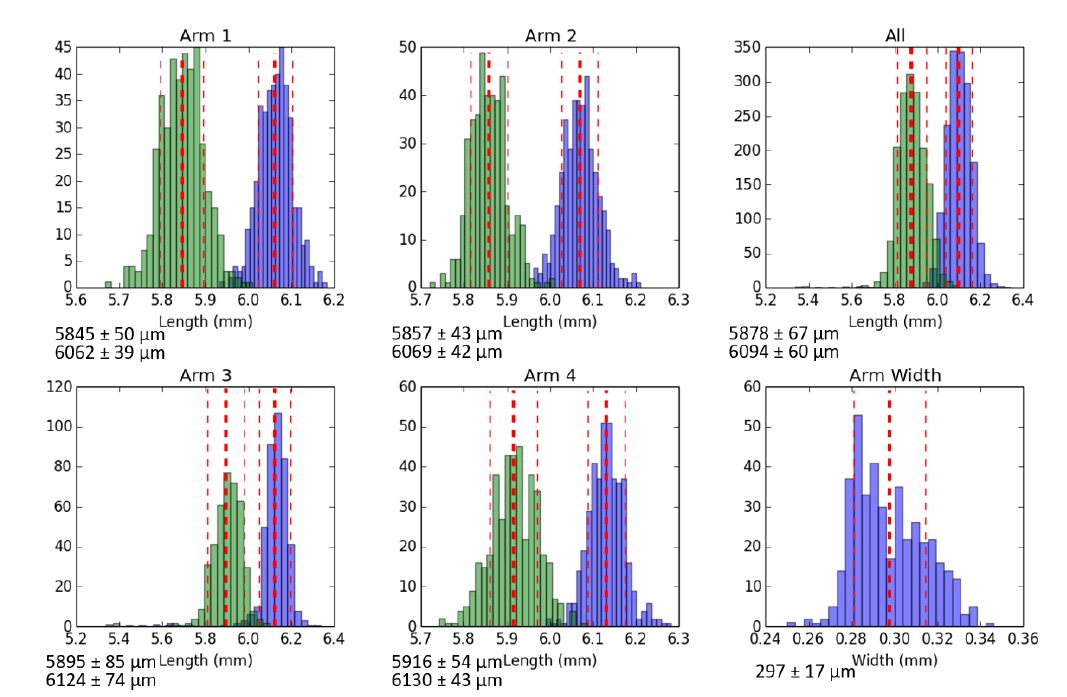
Figure A8. Histogram of dimensions for a subset of 400 spirals. Green bars are arm length measured from the center radius, purple bars are arm length measured from the center of the spiral, red lines are the average and the positive and negative standard deviation.